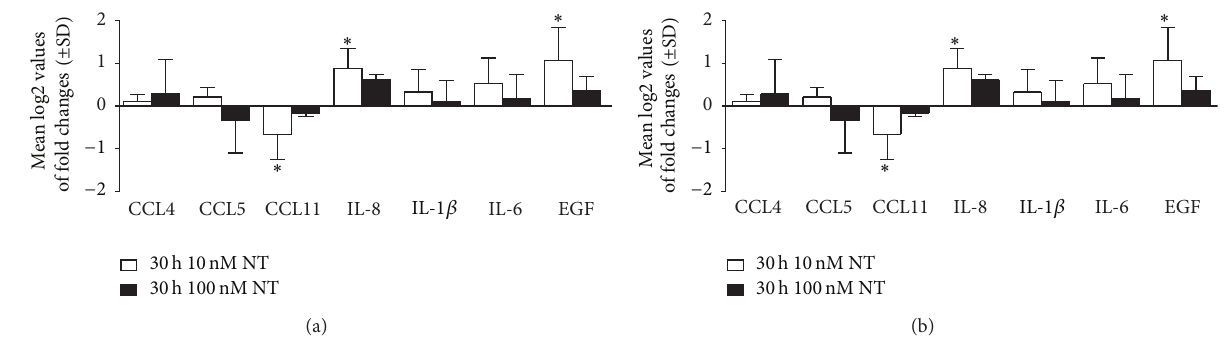
Figure 4: Modulation of gene expression by neurotensin under homeostatic and inflammatory conditions in BJ cells. Cells were maintained in culture medium (Ctrl) and treated with 10 nM of NT (white bars) or 100nM of NT (black bars) during 30h (a) or pretreated with 10nM (white bars) and 100nM (black bars) of NT during 24 h and stimulated with 1 𝜇 g of LPS during 6 h (b), at 37 ∘ C, with 5% CO 2 . Total RNA was isolated and retrotranscribed as indicated in Section 2. The mRNA levels were assessed by quantitative real-time RT-PCR. Gene expression is indicated as mean log2 values of fold changes relative to the control. Each value represents the mean ± SD from four independent experiments ( ∗ 𝑃 < 0.05 ; Kruskall-Wallis test followed by Dunn’s posttest statistical analysis between 10 and 100 nM of NT, 10, and 100nM of NT with the corresponding control, under homeostatic and inflammatory